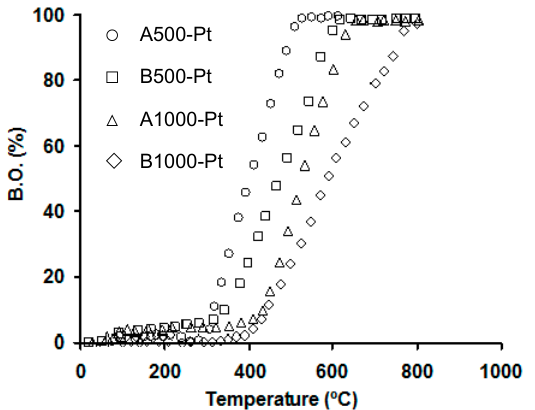
Figure 2. Percentage of burn-off (B.O.) in air against temperature for supported catalysts (A-samples) or doped (B-samples) carbonized at 500 and 1000 °C. Figure reprinted with permission from [56]. Copyright 2004, Elsevier.